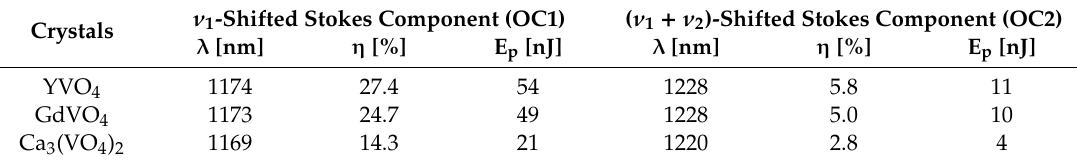
Table 1. The SRS characteristics in the YVO 4 , GdVO 4 , and Ca 3 (VO 4 ) 2 Raman lasers with OC1 and OC2, where λ is a generated wavelength, η is a slope efficiency, and E p is an output pulse energy.